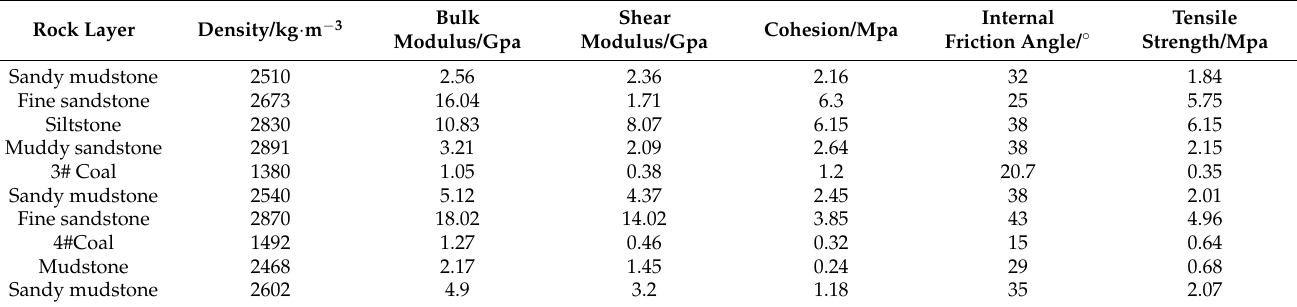
Table 5. Numerical simulation of physical and mechanical parameters of coal seams. Rock